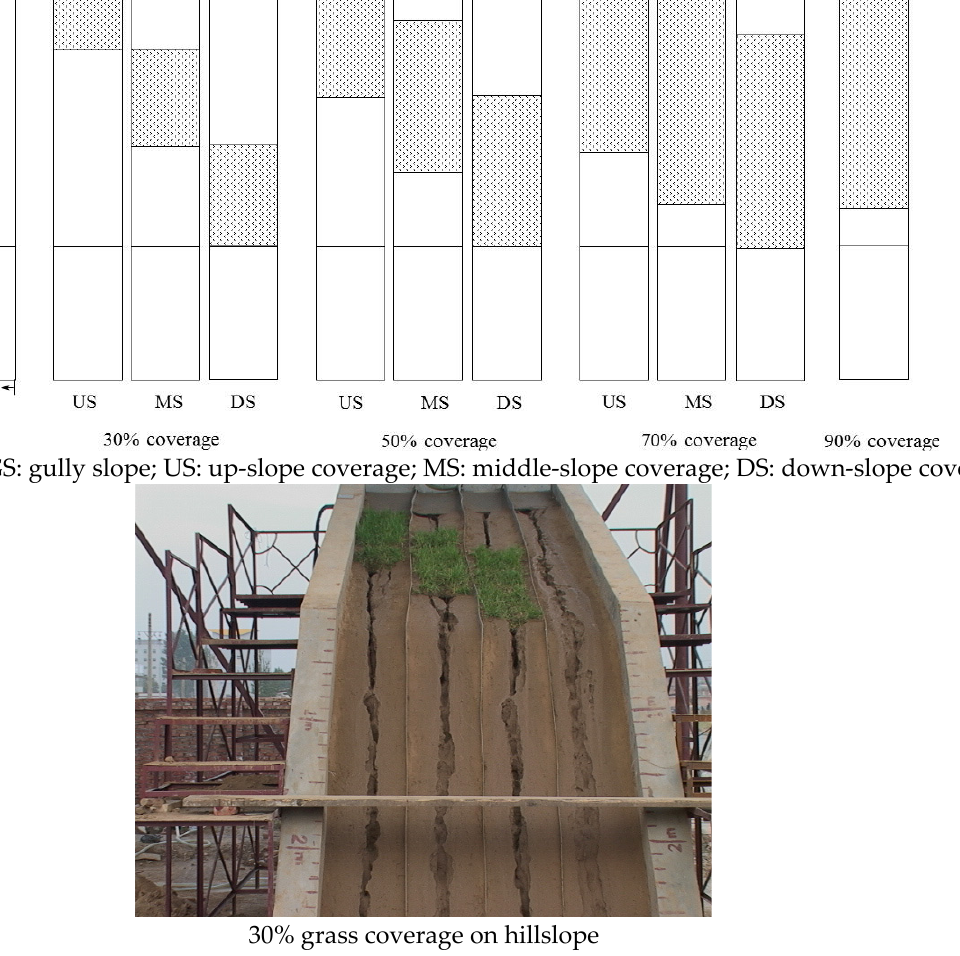
Figure 2. Schematic diagram of different grass coverage rates and different grass spatial arrangement patterns on soil box.